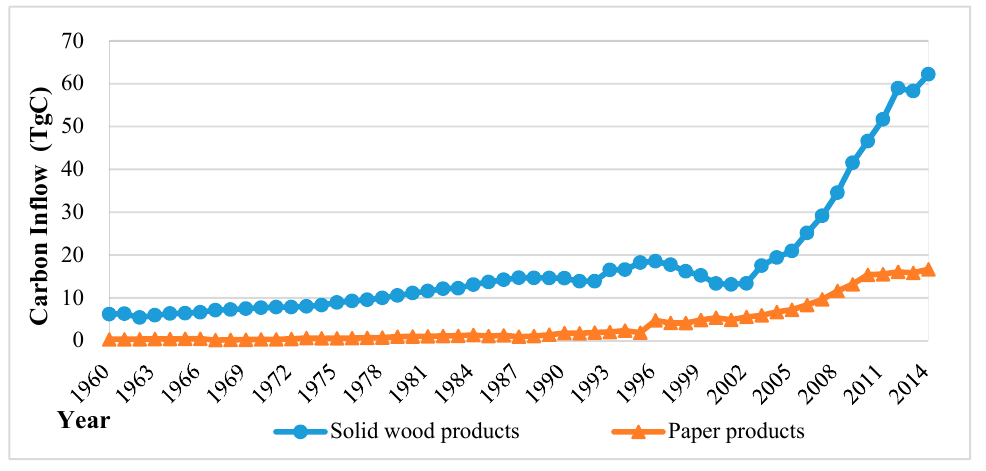
Figure 2. Carbon inflow of two categories of HWP from harvest in China from1960 to 2014.